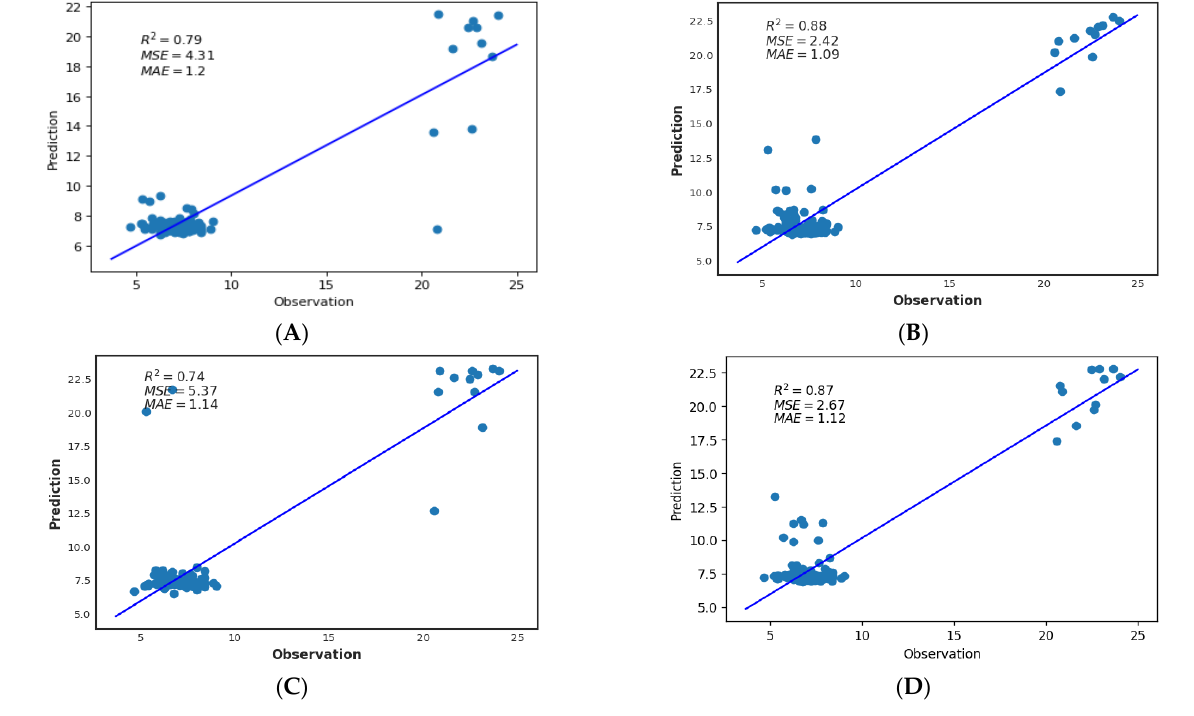
Figure 4. Scatter plots of the measured and estimated SMC derived from four ETD, RF, SVR, and XGBoost regression models using the Landsat 8 MSI data. ( A ) SVR model, ( B ) ETD, ( C ) XGBoost, ( D ) RF.